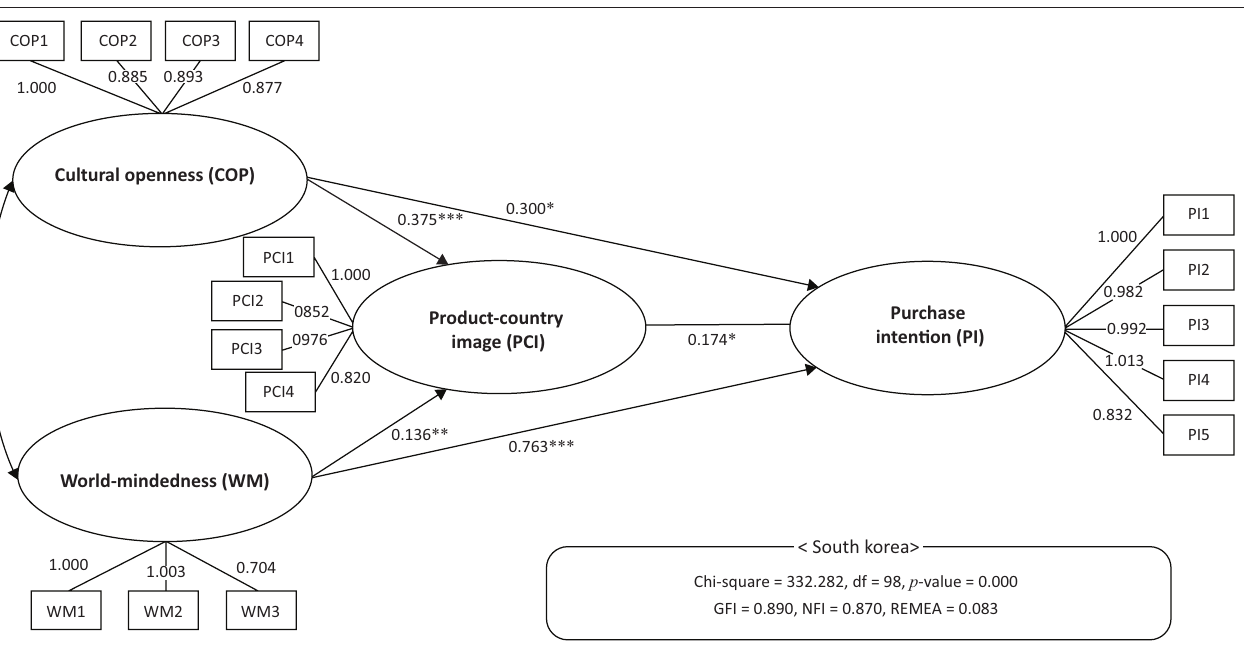
FIG URE 2: Structural model (South Korea).